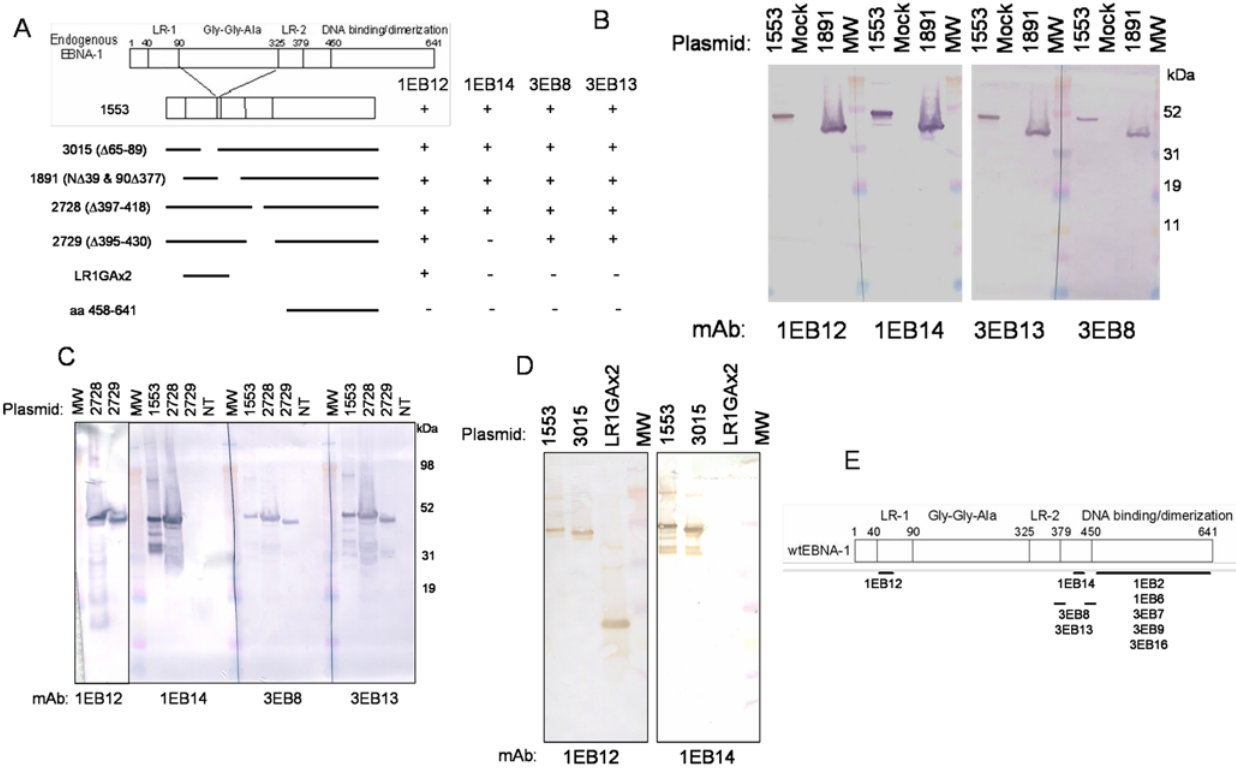
Figure 1. Epitope mapping of the N-terminal anti-EBNA1 mAbs. A) The constructs used to analyze mAb reactivity. Full length EBNA1 is shown at the top, numbered according to the B95-8 EBV strain. LR-1 and LR-2 (linking regions 1 & 2) are designated, as well as the GGA repeat region between amino acids 90 and 325. The C-terminus is largely composed of the DNA-binding and dimerization domain. 1553 encodes functionally wildtype EBNA1, but lacks the majority of the GGA stretch. The remaining EBNA1 derivatives are derived from the 1553 construct and thus carry the GGA deletion. B) 1891 was transfected into 293 cells and whole cell extract was analyzed by Western blot. The first lane in each series contains purified 1553, the second lane is untransfected 293 whole cell extract (mock), and the third lane is whole cell extract from cells transfected with the 1891 plasmid. Equal concentrations of purified mAbs were used to probed the Western blots. C) Plasmids 2728 and 2729 were transfected into 293 cells and whole cell extract was analyzed by Western blot. NT, not transfected. Equal concentrations of purified mAbs were used to probe the Western blots. D) Purified EBNA1 derivatives were analyzed by Western blot for mAb reactivity. Equal concentrations of mAb 1EB12 or mAb 1EB14 were used to probe the Western blots. E) Summary of the anti-EBNA1 mAb epitopes. The schematic shows endogenous EBNA1 protein, numbered according to the B95-8 strain of EBV, and the domain structure. The lines represent the various epitope regions and the mAbs that interact in that area are written below. MW is molecular